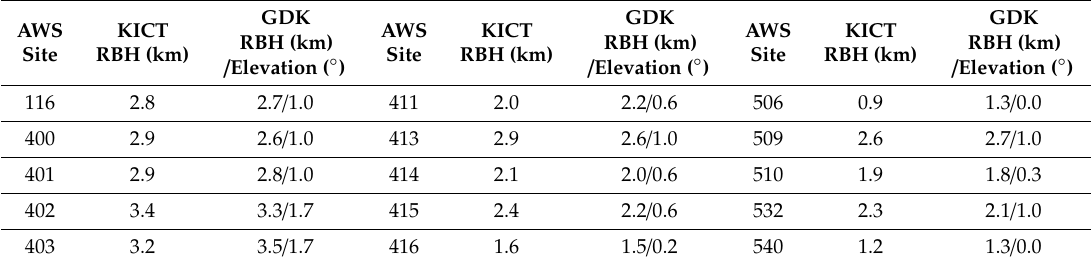
Figure 10. Scatter plots of the X-band radar reflectivity ( a ) before attenuation correction and after ( b ) DPRm, ( c ) SMLm, ( d ) RSMLm, ( e ) RMMLm, and ( f ) MMLm against reflectivity retrieved by the S-band radar over the 36 AWS sites during the convective rainfall case. Scatter plots of X-band radar reflectivity (g) before attenuation correction and after ( h ) DPRm, ( i ) SMLm, ( j ) RSMLm, ( k ) RMMLm, and ( l ) MMLm against reflectivity retrieved by the S-band radar over 36 AWS sites during the stratiform rainfall case. Table 4. Radar beam heights (RBH) over the 36 AWS